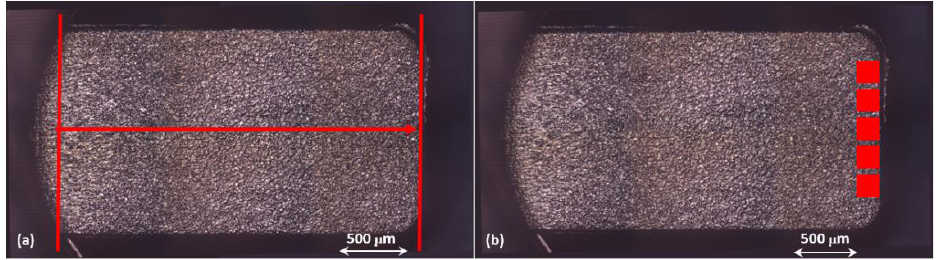
Figure 3. Red lines and areas indicate length ( a ) and the surface ( b ), respectively, considered for the measurements.